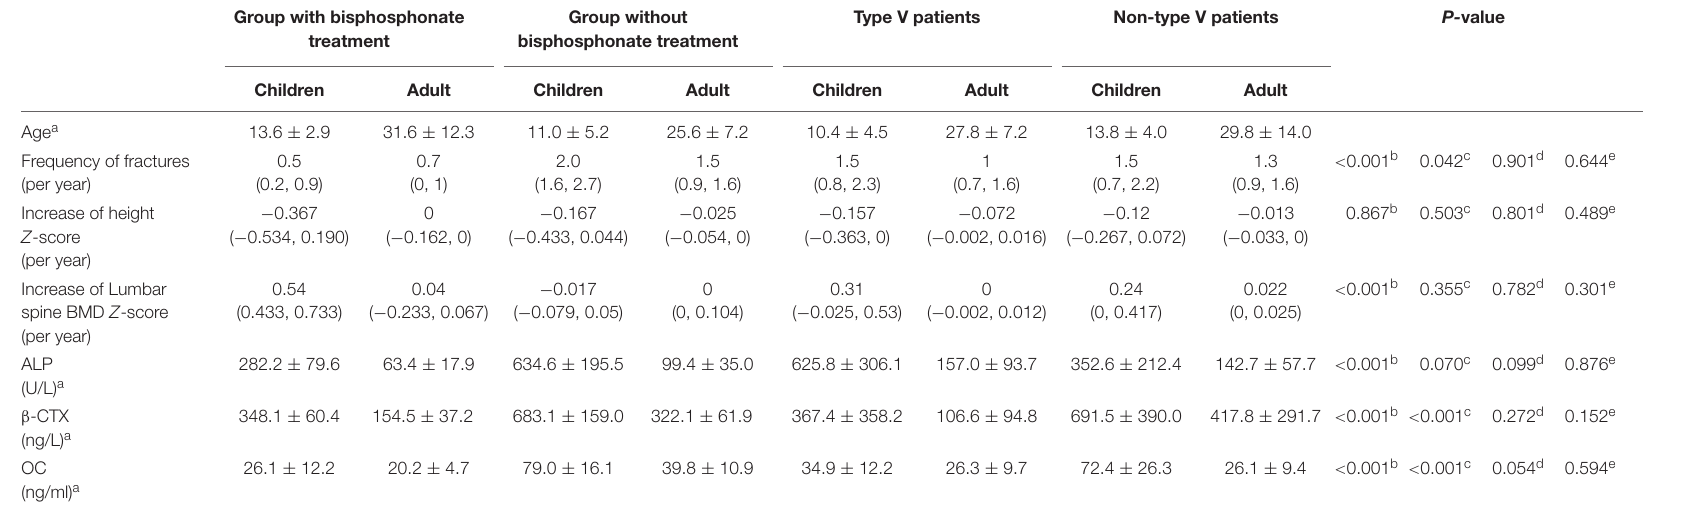
a Data were obtained at the time of the last follow-up visit. b Children with bisphosphonate treatment vs. children without bisphosphonate treatment. c Adult with bisphosphonate treatment vs. adult without bisphosphonate treatment. d Children of OI type V patients vs. children of non-type V patients. e Adult of OI type V patients vs. adult of non-type V patients; BMD, bone mineral density; ALP, alkaline phosphatase; β -CTX, beta cross-linked carboxy-terminal telopeptide of type I collagen; OC,